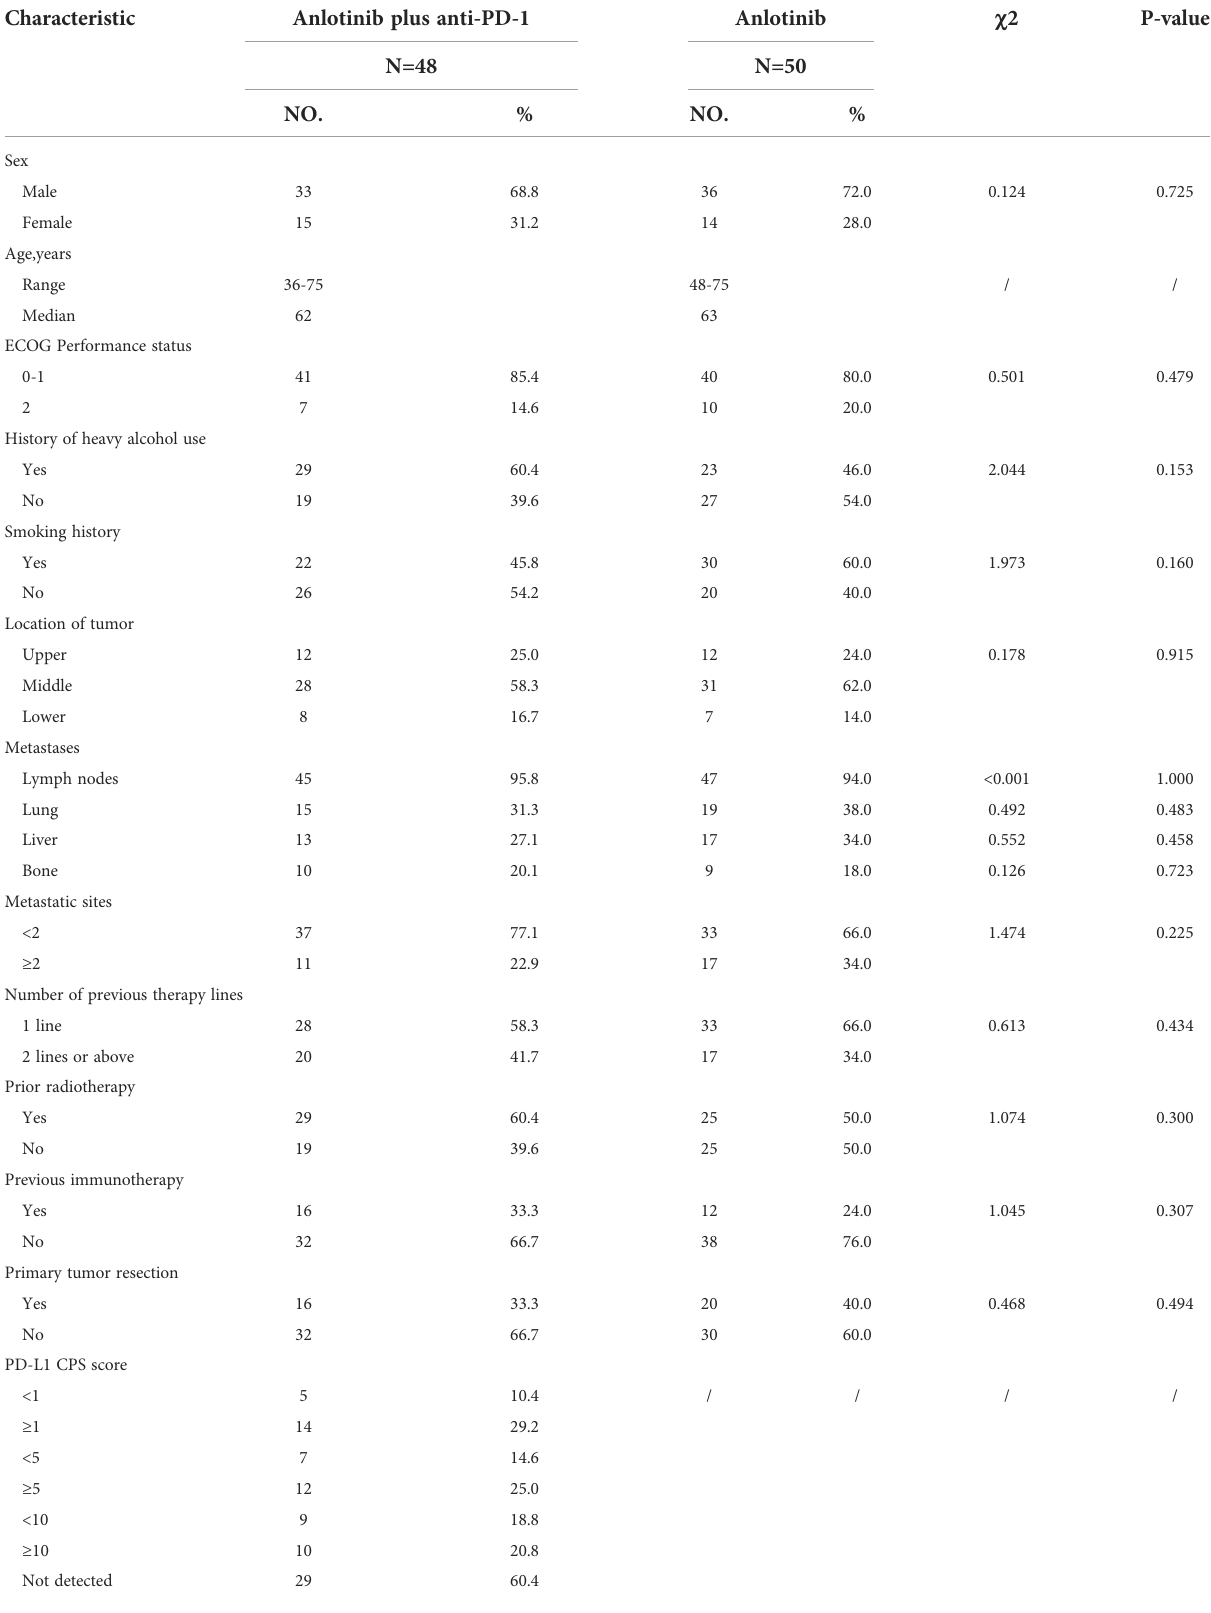
TABLE 1 Baseline Patient